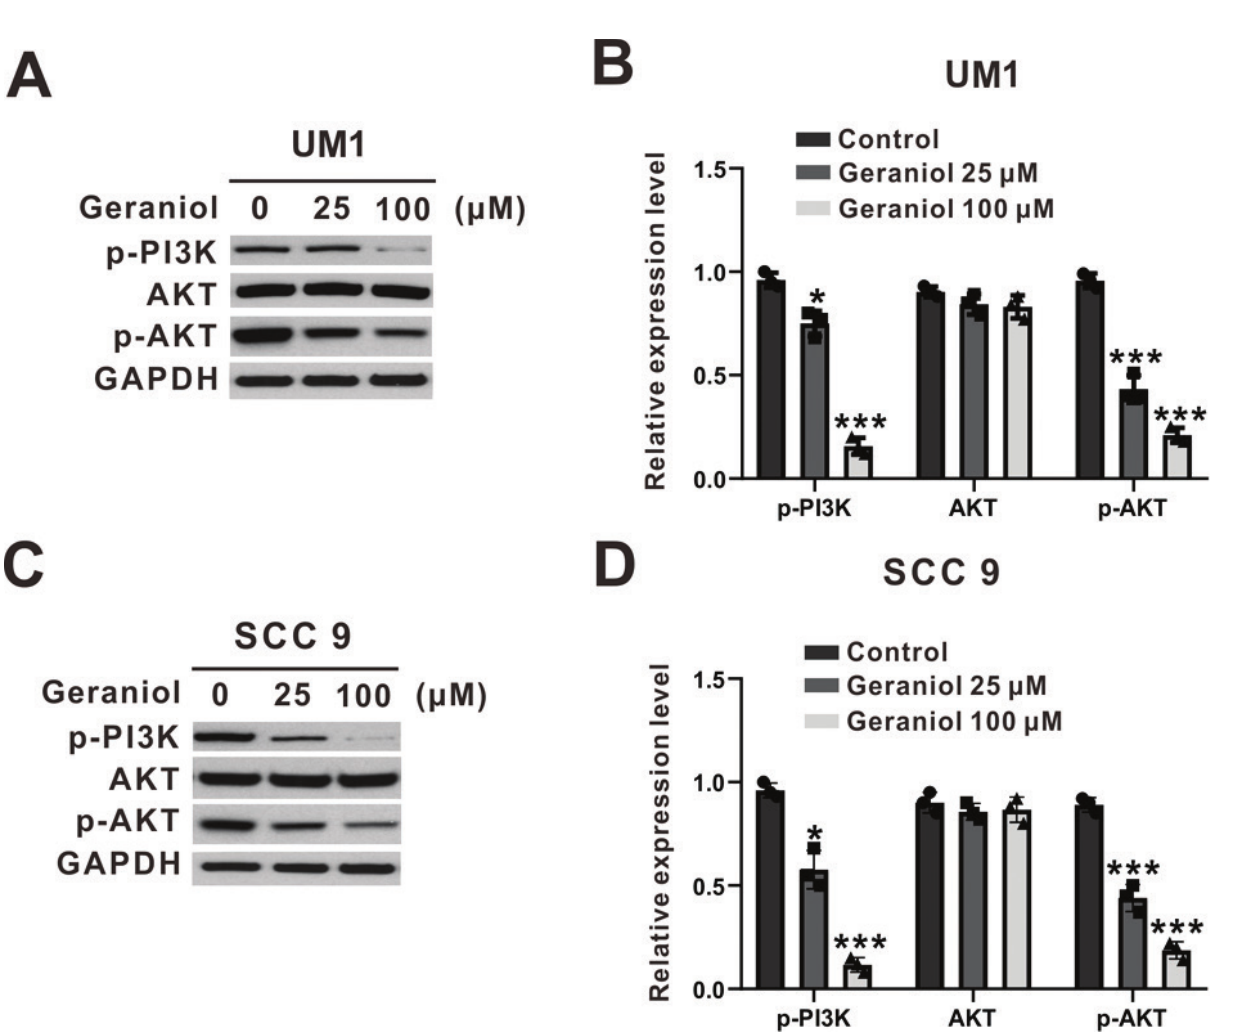
Fig. 4. Geraniol inhibited the PI3K/AKT signaling pathway. Cells were seeded and treated geraniol for 48 h. (A–D) The levels of PI3K, p-AKT, and AKT were determined by Western blot. The bar chart showed the quantitative results. Data are presented as means ± standard deviation (SD) for three independent experiments. * P < 0.05 and *** P < 0.001, compared to the control